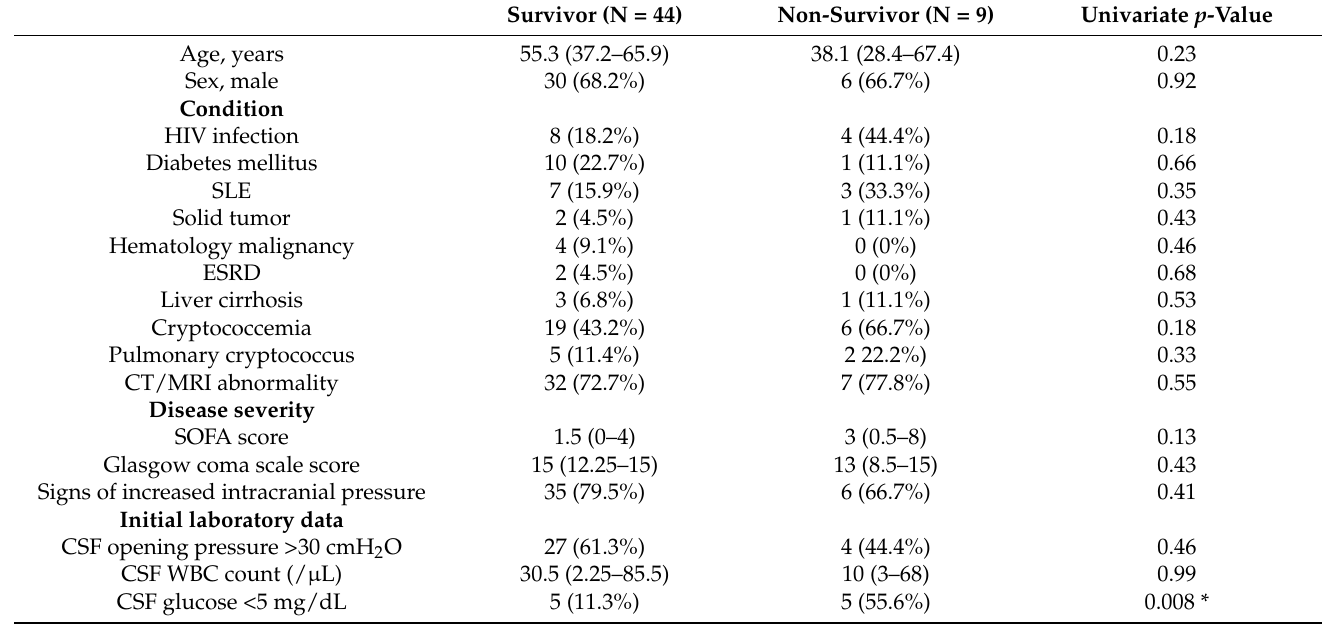
Table 3. Factors associated with 14-day mortality of patients with cryptococcal